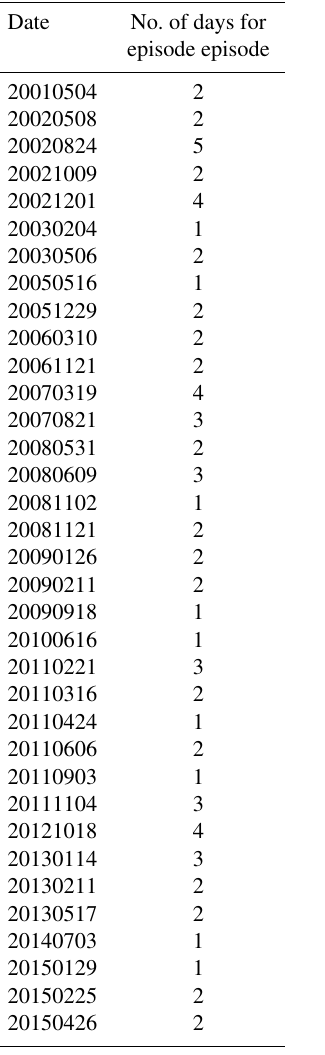
Table 2. Date (YYYYMMDD) and number of days for heavy/persistent precipitation episodes selected for the